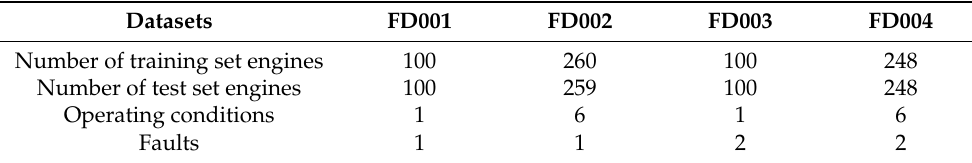
Table 1. Dataset description.